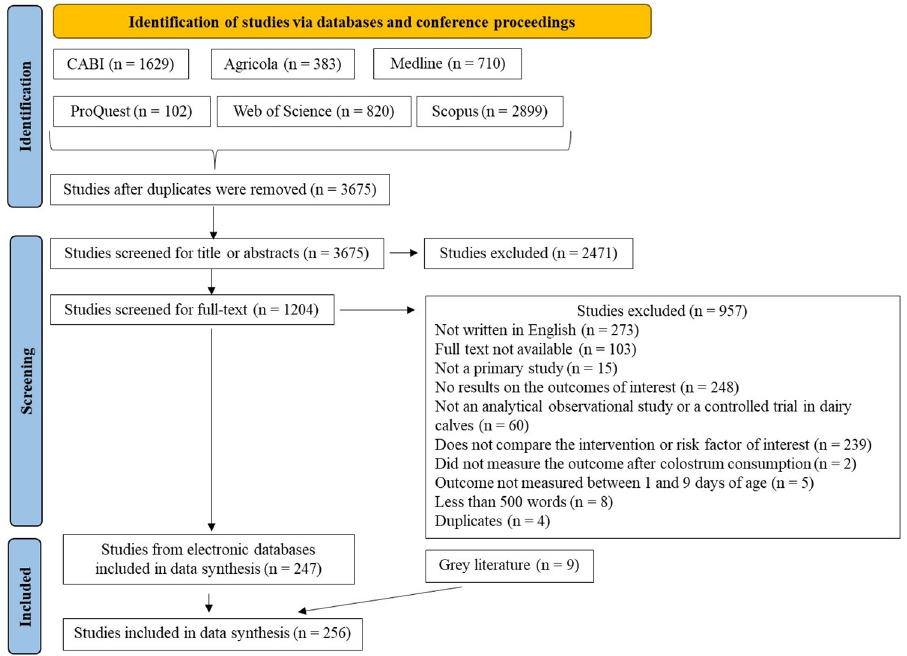
Fig 1. Flow chart of studies identified, screened, and included in the data analysis